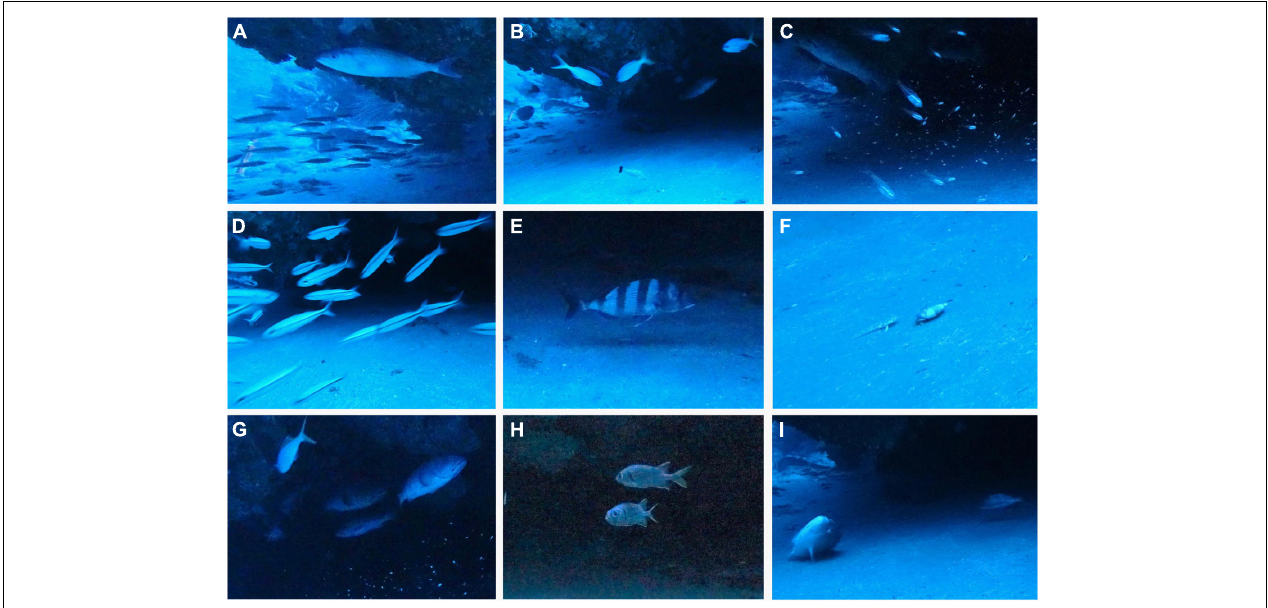
FIGURE 8 | Photographs of fishes that were in the cave when no coelacanth was present, showing what appears to be a species of jobfish ( Aphareus sp., snappers, Lutjanidae) near the ceiling (A) above a school of fusilers, Caesio xanthalytos (Caesionidae) that have a yellowish lateral stripe that are shown in (D) , 3 yellowtail blue snappers, Paracaesio xanthura , near the ceiling with a grouper farther back in the cave, and a species of hogfish with a black tail ( Bodianus sp.; Labridae) in front looking at a hermit crab in a shell on the bottom (B) , many small cardinal fish (possibly Ostorhinchus neotes ) with a grouper near the ceiling (C) , a santer seabream, Cheimerius nufar (Sparidae) (E) , what appears to be a species of sandperch, Parapercis (Pinguipedidae) that was curious about the hermit crab (F) , a P. xanthura (upper left) and 3 groupers (G) , 2 shoulderbar soldierfish, Myripristis kuntee in the midwater of the cave (H) , and a sparid cleaning its body by brushing against the bottom sand (I)